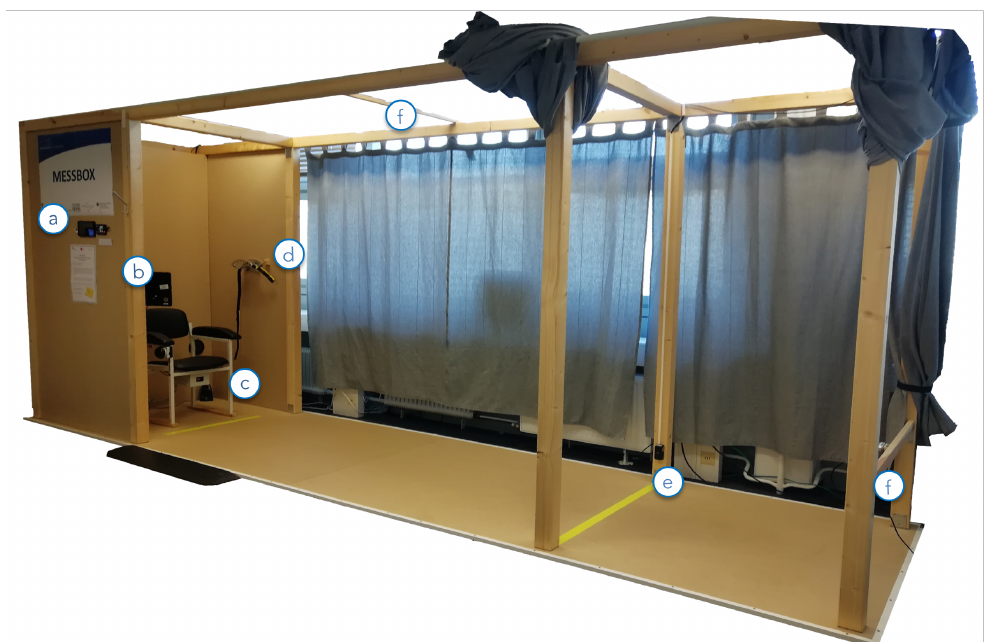
Figure 1. The USS consisting of: ( a ) the introductory display and an RFID authentication device, ( b ) the main display for user-interaction, ( c ) the integrated aTUG chair with additional LBs, ( d ) a sensor-belt including an inertial sensor, ( e ) light barriers at a 3 m walking distance, and ( f ) the Intel RealSense TM D435 Depth image camera placed approximately 4 m from the chair and from the upper level facing it.